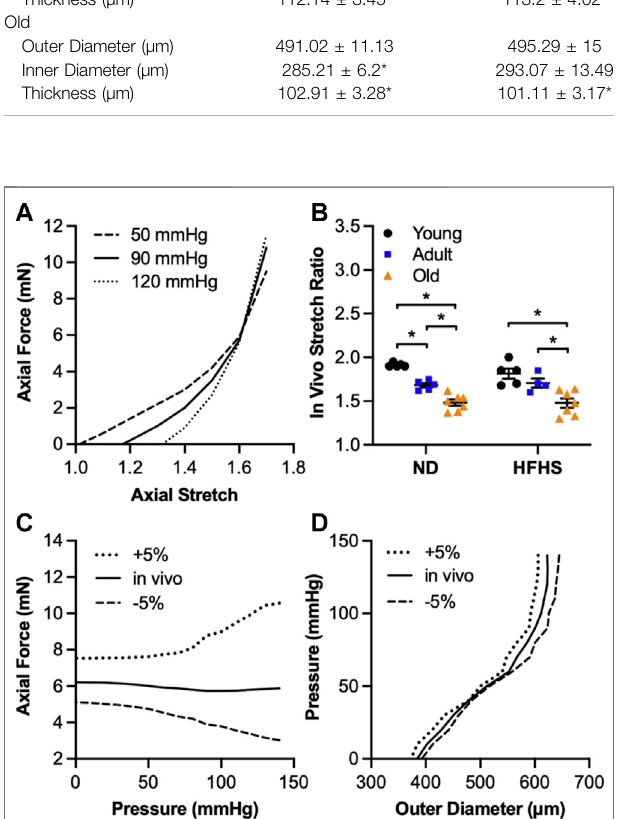
FIGURE1| Invivo axialstretchratioandtypicalarterialresponseundera pressure-diameter testing. (A) : Estimation of the in vivo axial stretch ratio as the intersection point of the three axial force-stretch curves at different pressure values (50 mmHg, 90 mmHg, 120 mmHg). (B) : Estimated in vivo ratio for the age (young, adult and old) and diet (ND and HFHS) groups. (C,D) : Typical axial force-pressure and pressure-outer diameter response of arteries at three different axial stretches ( in vivo , 5% above and below in vivo ) (* p < 0.05).